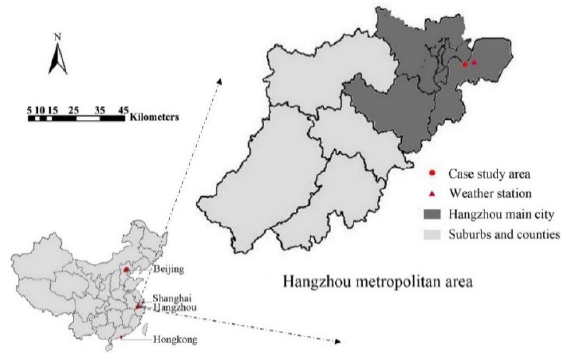
Figure 2. Location of Hangzhou city and the fixed weather station.